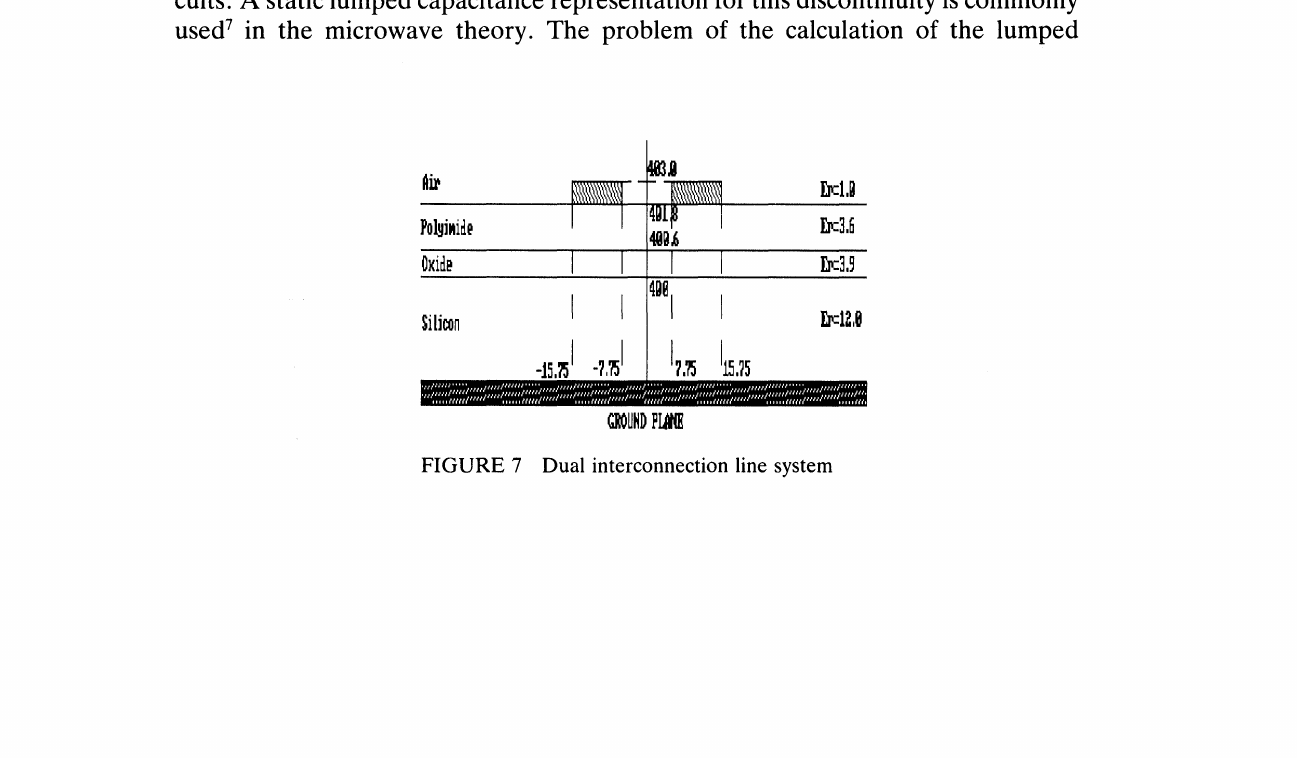
FIGURE 7 Dual interconnection line